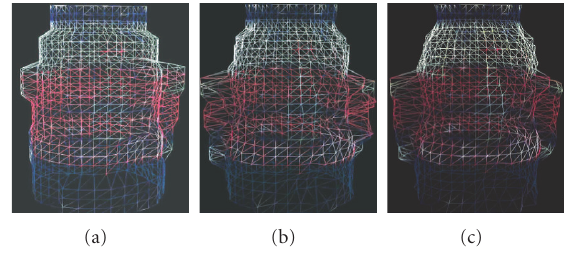
Figure 5: Interpolating and reconstructing mesh of nutcracker model when 2 (left), 4 (middle), and 8 of 16 packets are received.